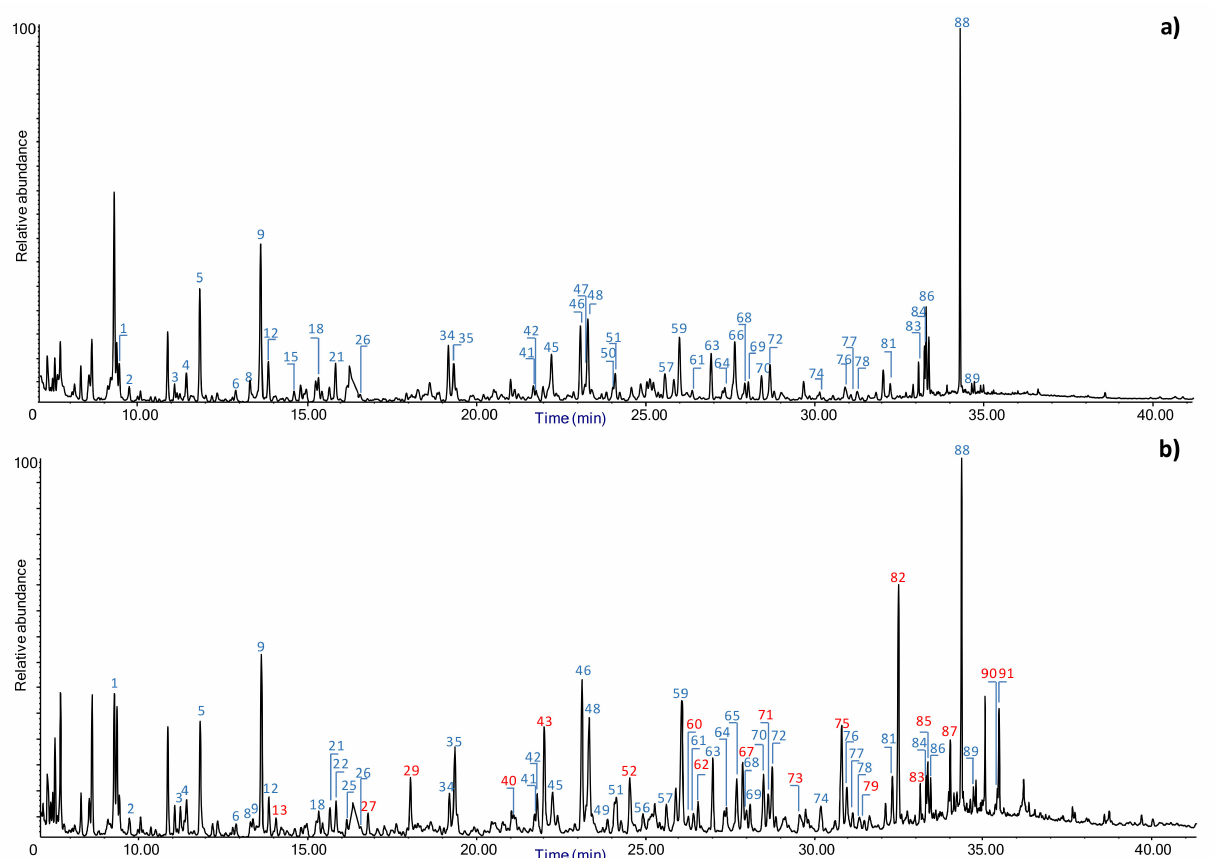
Figure 9. Chromatographic profiles obtained by Py(HMDS)-GC/MS ( a ) archaeological pine (specimen 47) and (b ) archaeo- logical pine treated with FB01 (specimen 22). Lignin pyrolysis products, which were very low or absent in archaeological pine, were used to evaluate lignin penetration in test specimens. These are labelled in red script. Peak numbers refer